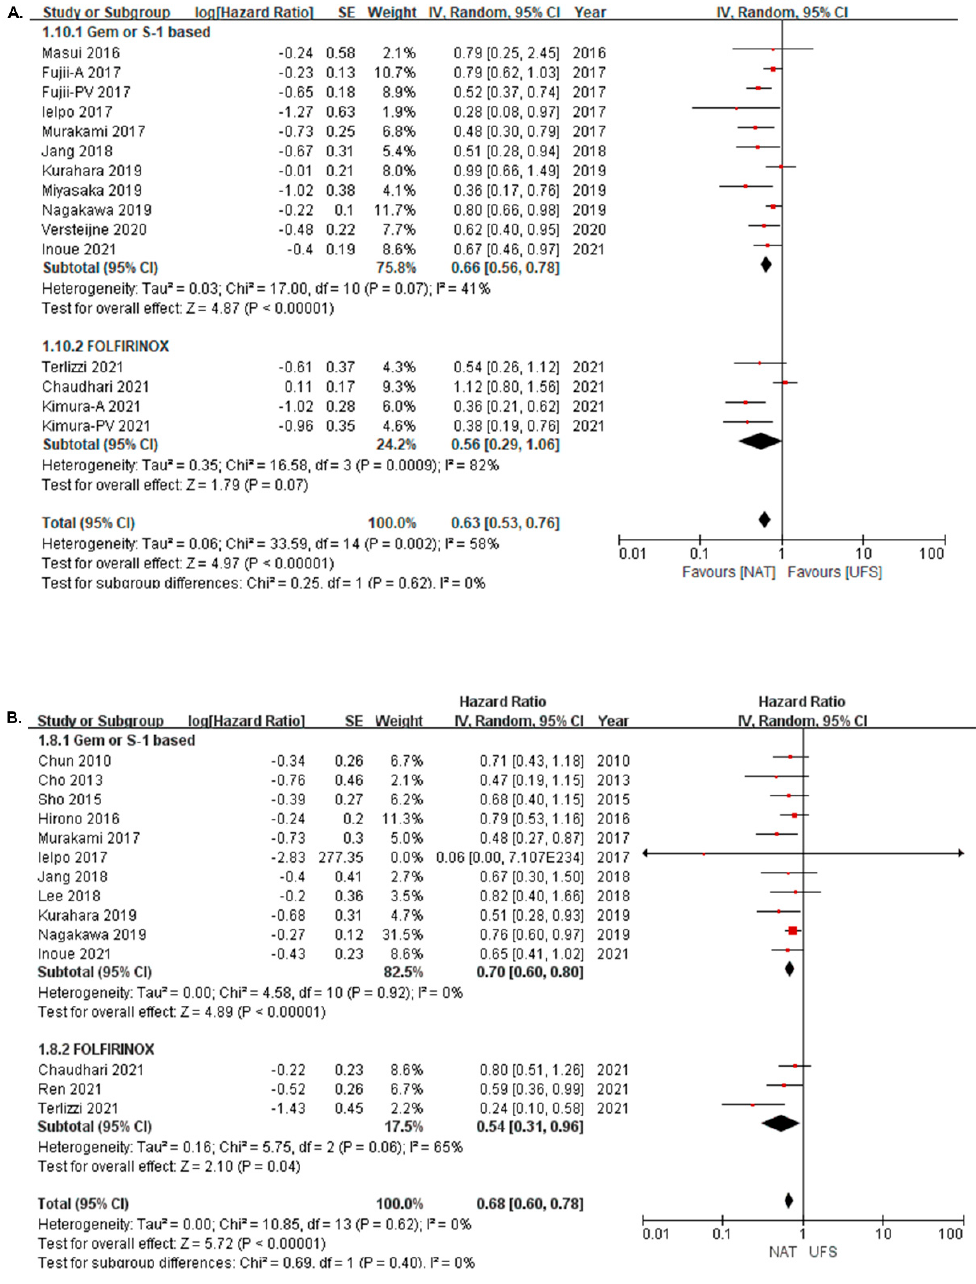
Figure 3. Overall survival of NAT versus UFS according to chemotherapy regimen ( A ) in intention-to-treat analysis; (1.10.1) gemcitabine- or S-1-based [6,10,12,20,21,23–27]; (1.10.2) FOLFIRINOX [28,29,31]; ( B ) in resected group; (1.8.1) gemcitabine- or S-1-based [6,9,12,17–19,21–23,25,27]; (1.10.2) FOLFIRINOX [28,30,31]. Red squares correspond to individual studies. Squares size is proportional to the weight of the study while black diamonds shapes correspond to pooled studies.